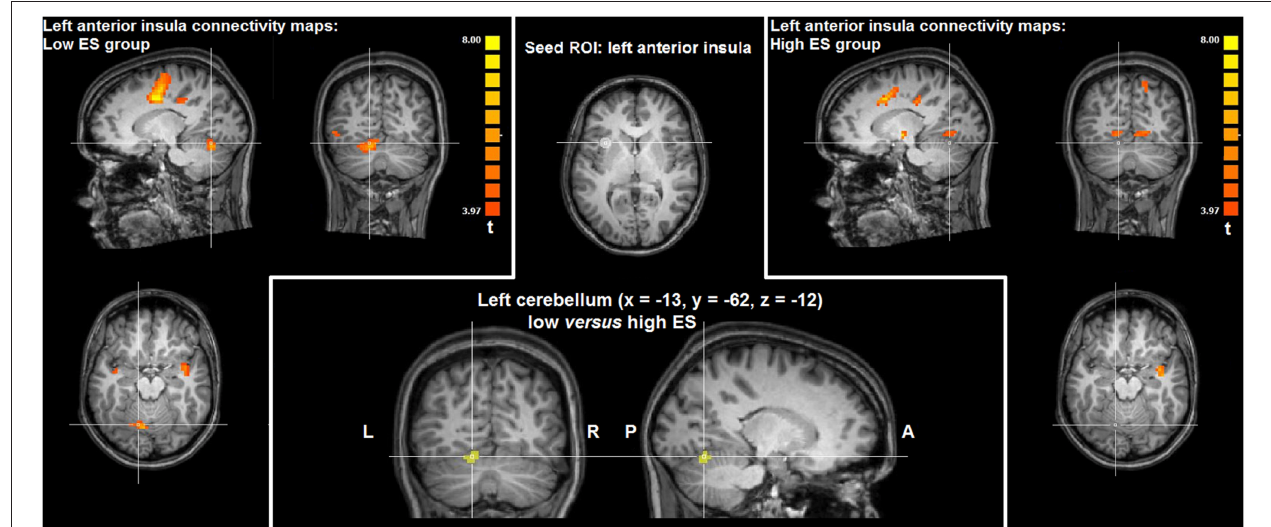
FIGURE 3 | Group statistical maps of intrinsic functional connectivity analysis based on the left anterior insula seed ROI showing significantly higher connectivity ( t > 3.20 , p < 0.05 corrected) in left cerebellum in the low ES group, compared to the high ES group.